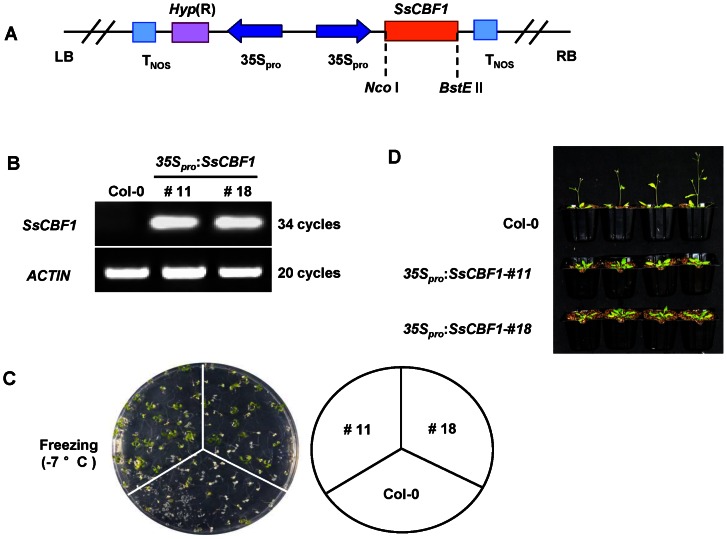
Freezing tolerance and delayed flowering phenotype of 35S:SsCBF1 transgenic Arabidopsis.(A) Schematic representation of the construct used for Arabidopsis transformation of the SsCBF1 gene. (B) Relative expression of SsCBF1 in Col-0 and two T3 generation transgenic lines (#11 and #18). Total RNA was extracted from 10-day-old seedlings, then analyzed by semi-quantitative RT-PCR. ACTIN7 gene was used as an internal control. (C) Comparison of freezing tolerance between Col-0 and two transgenic lines. See Methods for details. The right diagram indicates different genotypes used in the assay. (D) Late flowering phenotype of transgenic Arabidopsis overexpressing SsCBF1. Col-0 and two SsCBF1 OE lines were grown under the same conditions as described in Methods. Four-week-old plants were photographed.